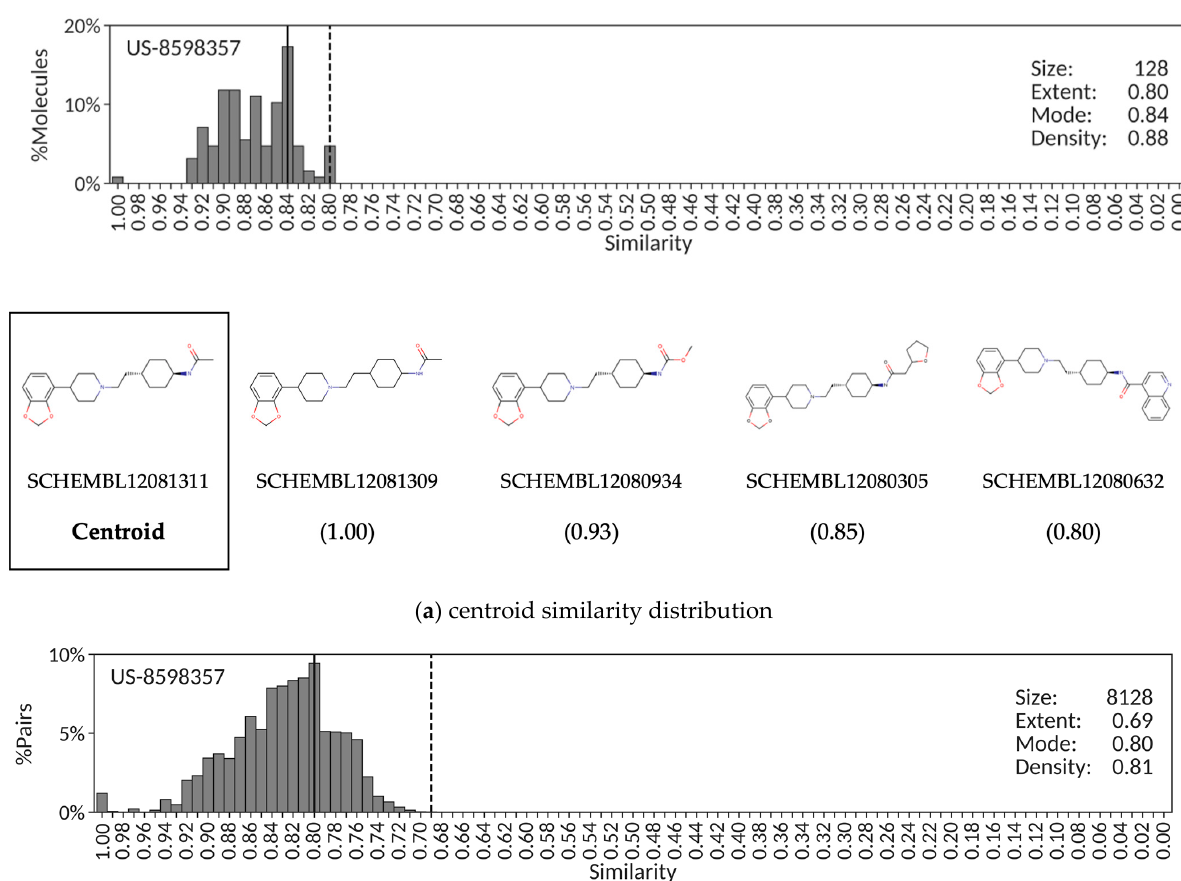
Figure 1. Centroid ( a ) and all pairwise ( b ) similarity distributions for the set of exemplified molecules in SureChEMBLccs patent US-8598357. Additionally, included ( a ) is a sample of chemical structures with their SCHEMBL identifiers and similarity values (in parenthesis). The extent and mode are indicated, respectively, by vertically dashed and solid lines.